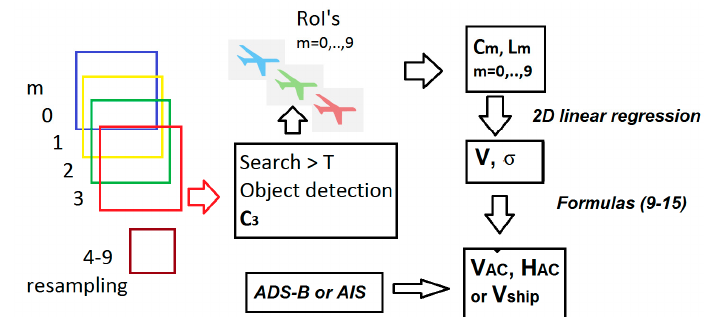
Figure 1. Flow chart of algorithm: For a given scene the m = 0, ... , 9 high resolution S2 multispectral images are selected. Search and detection of objects above a threshold T is done for the red band m = 3. For each object, a region of interest (RoI) around the object center 𝑐⃗ (cid:2871) is chosen for all ten images, where m = 4–9, are resampled to 10 m pixel size. The center 𝑐⃗ (cid:3040) and length 𝐿(cid:4652)⃗ (cid:3040) are calculated for m = 0, ..., 9. From 2D linear regression (3) of the variance σ , the apparent velocity 𝑉(cid:4652)⃗ is found and inserted in (9–15), whereby the aircraft velocity and altitude or ship velocity is found. By comparing to ADS-B or AIS, the velocities, altitudes and positions are validated.